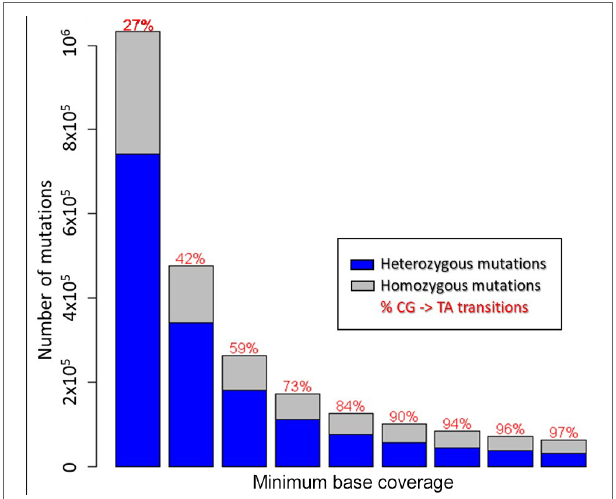
FIGURE 2 | Number of mutations and their zygosity depending on mutant allele coverage.